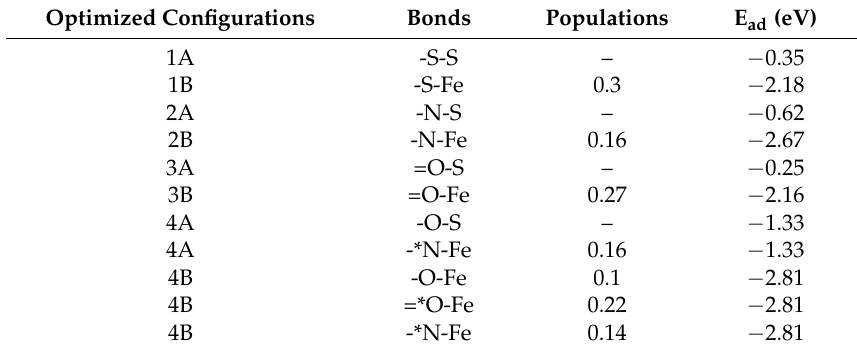
Table 5. Adsorption energies and Mulliken bond populations of the interaction between cysteine and pyrite (1 0 0) surface (negative sign represents exothermic